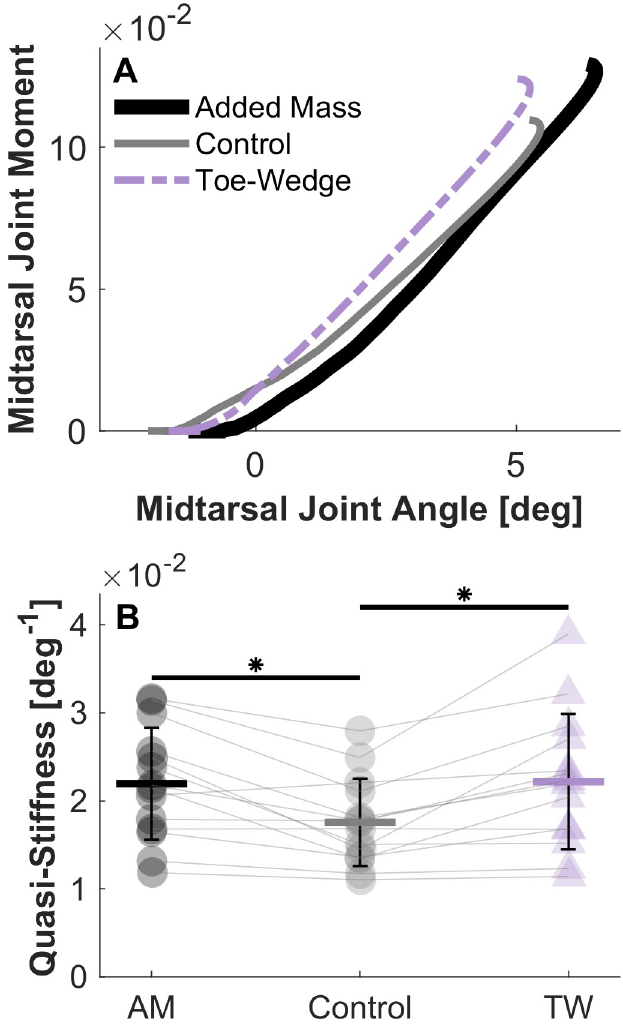
Fig 6. Midtarsal joint sagittal plane quasi-stiffness. (A) Mean sagittal plane resultant midtarsal joint moment profile and sagittal plane angle from the time the center of pressure crossed the joint to the maximum moment in the added mass, control, and toe-wedge conditions. (B) Sagittal plane midtarsal joint quasi-stiffness was greater in the toe-wedge (TW) and added mass (AM) conditions than in the control condition ( � indicates statistical significance at α = 0.017 after Bonferroni correction). Values for each participant are displayed in each condition, with grey lines connecting a single participant across conditions. Error bars represent the standard